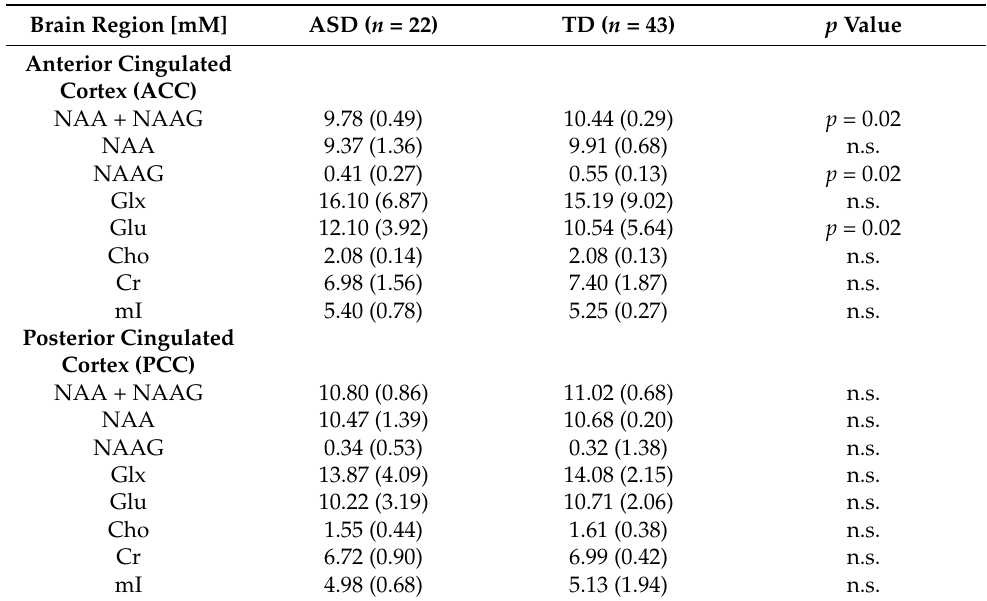
Table 2. Case–control analysis of absolute metabolic concentrations according to the cerebral regions: ASD vs. TD values for N -acetyl-aspartate (NAA), N -acetylaspartyl-glutamate (NAAG), glutamate + glutamine (Glx), glutamate (Glu), creatine (Cr), choline (Cho), and myoinositol (mI) (absolute concentrations are group means). Regions = anterior cingulate cortex and posterior cingulate cortex. p < 0.05 considered significantly different, while n.s. represents non-significant results.